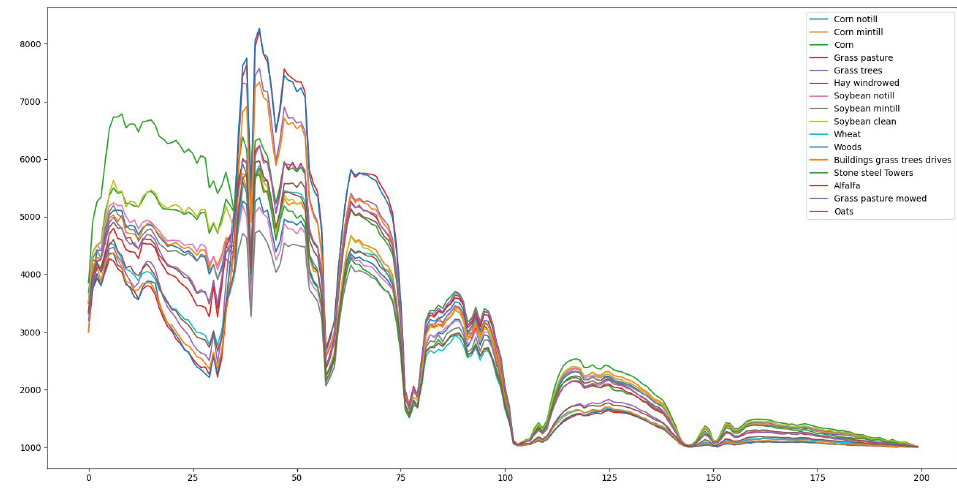
Figure 4. Spectrum of each material in the Indian Pines hyperspectral image. Table 3. Number of training and testing samples for the different classes in Indian Pine dataset. Class